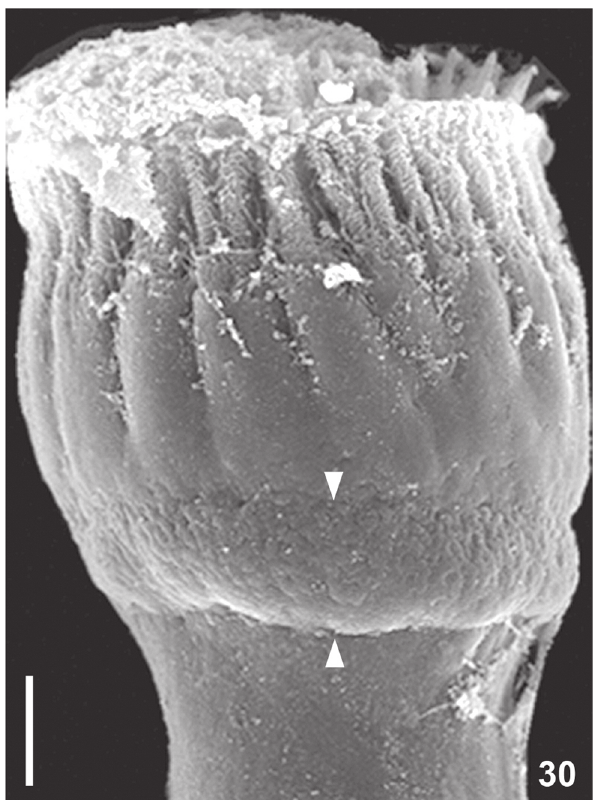
Figure 30. Temnocephala iheringi , SEM photomicrograph of the introvert, showing the conspicuous thickening on the base of the swelling (head arrows), bar = 10